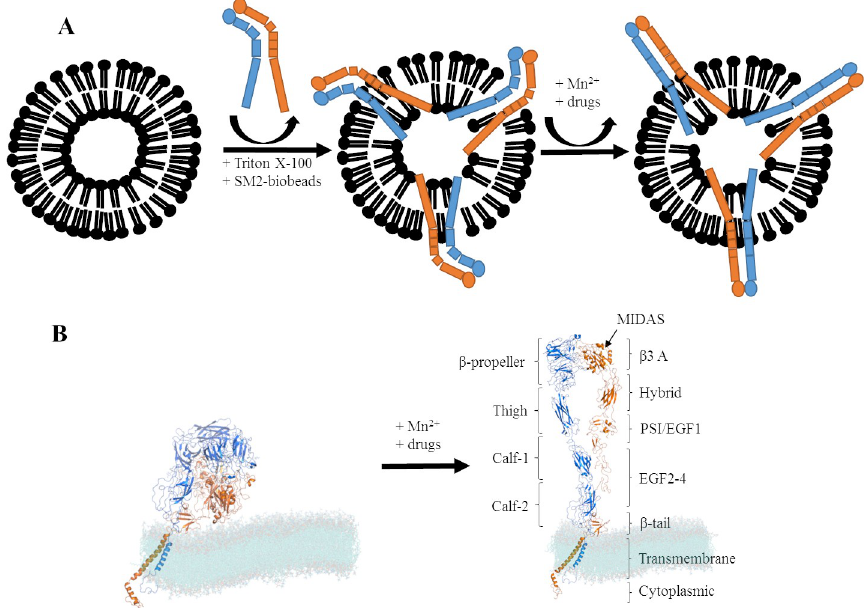
Fig 1. Schematic illustration of the proteoliposomes and structure of integrin α IIb β 3. A) Schematic illustration of the proteoliposomes as obtained after the reconstitution procedure before adsorption on SiO 2 surface. α IIb β 3 ( α IIb- subunit in blue and β 3-subunit in orange) is reconstituted into liposomes and treated with Triton X-100 as well as biobeads and activated by manganese ions (Mn 2+ ) or drugs. B) Structure of α IIb β 3 in bent (left) and open/active (right) conformation in a DMPG:DMPC (1:20) lipid membrane (cyan). The integrin model combines the α IIb β 3 transmembrane domain (PDB-code 2k9j) and ectodomain (PDB-code 3fcs), missing residues were added as random coils. The VMD 1.9. and PyMOL 2.1. softwarepackages were used to create this figure.